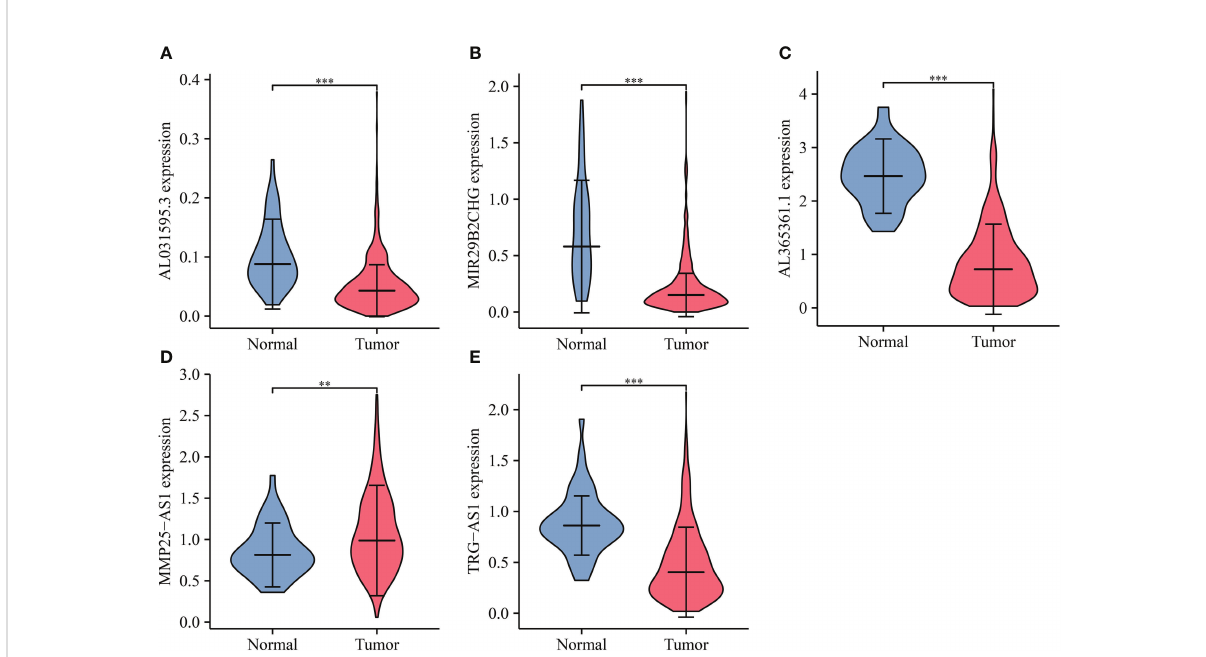
FIGURE 11 miR-556-5p-related lncRNA expression levels in LUSC. (A) AL031595.3; (B) MIR29B2CH; (C) AL365361.1; (D) MMP25-AS1; (E) TRG-AS1. LUSC, lung squamous cell carcinoma; **P < 0.01; ***P < 0.001.